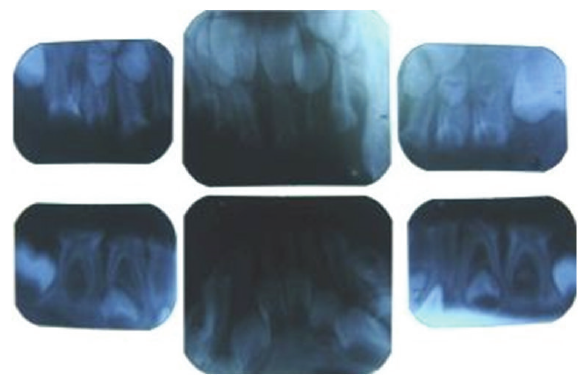
Figure 2: Periapical radiographs showing